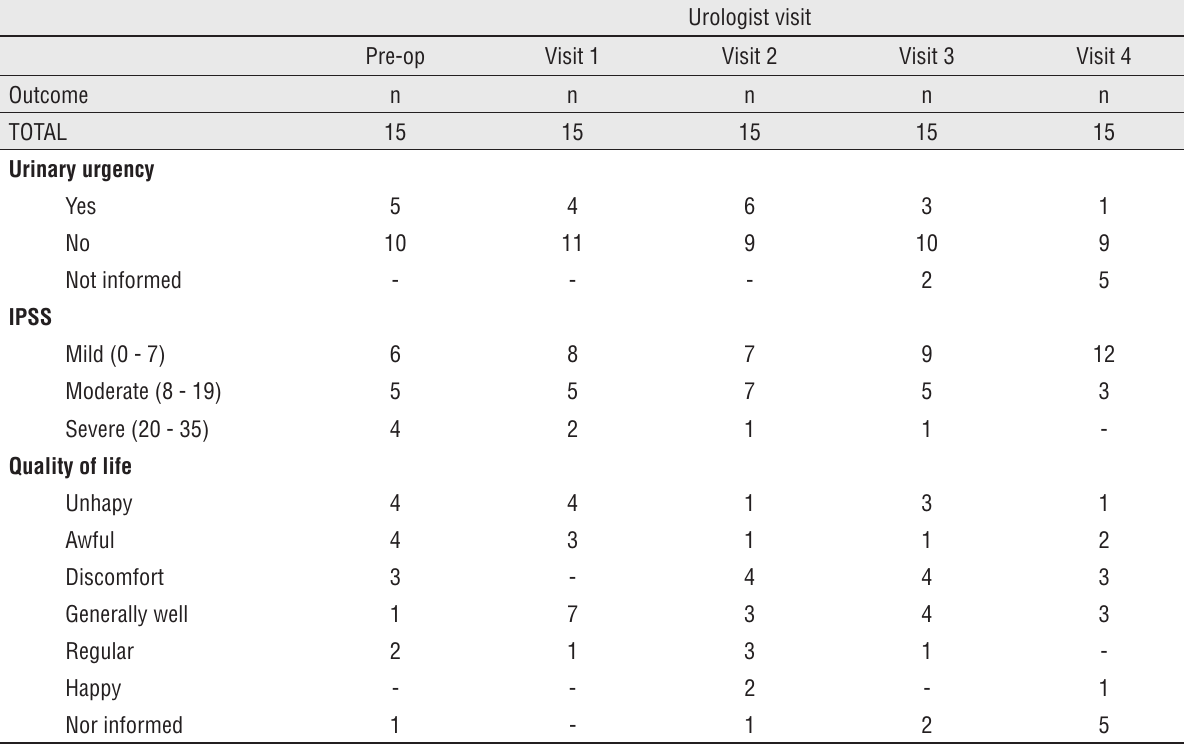
Table 2 - Urinary urgency, IPSS and quality of life per urologist